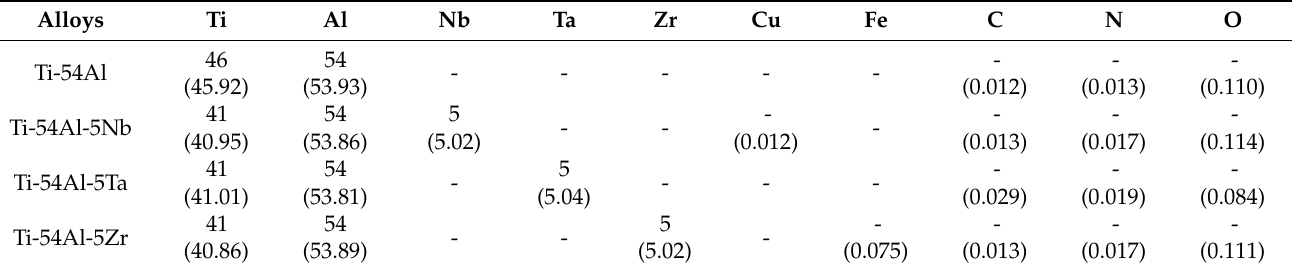
Table 1. Nominal composition of Ti-54Al-5X in at.% and measured concentration in brackets